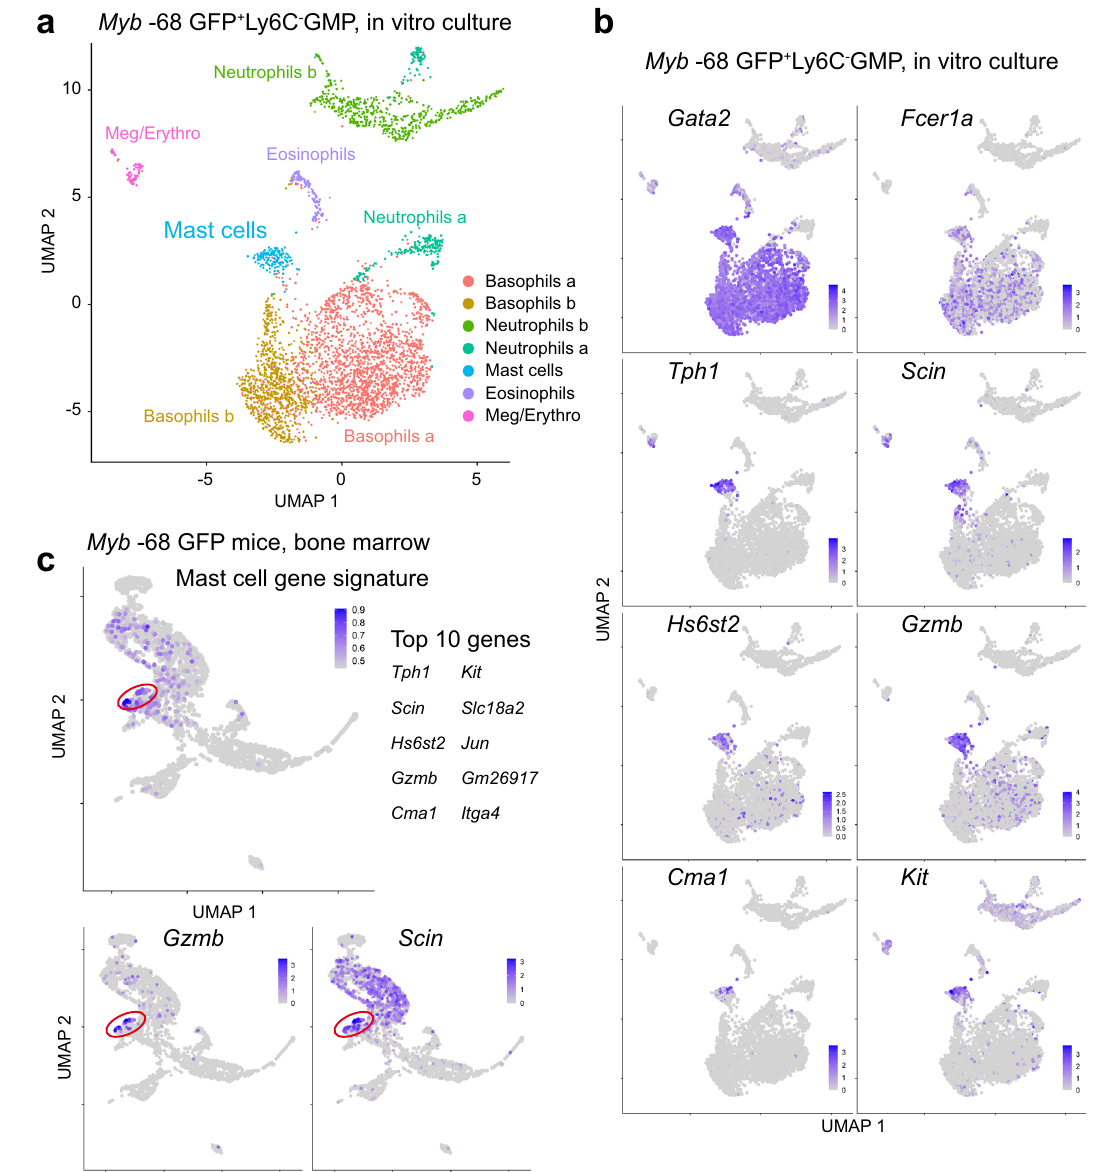
Fig.8|IntegrationoftwoscRNA-seqdatasetsidenti fi edbonemarrowcellswith a gene signature of immature mast cells. a UMAP visualization of in vitro mast cell culture. FACS-sorted Myb -68 GFP + Fc ε R1 α - Ly6C - GMPs were cultured with IL-3 for3days,andthenanalyzed.Clusterswereannotatedaccordingtotheexpression of known feature genes. b UMAP projection of selected mast cell signature genes. c UMAP projection of the mast cell gene signature (upper) and selected mast cell